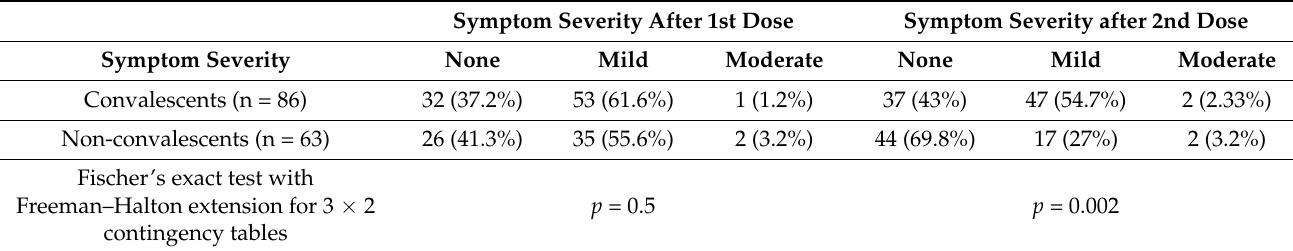
Table 4. Reported post-vaccine symptom severity across the COVID-19 convalescent and non- convalescent